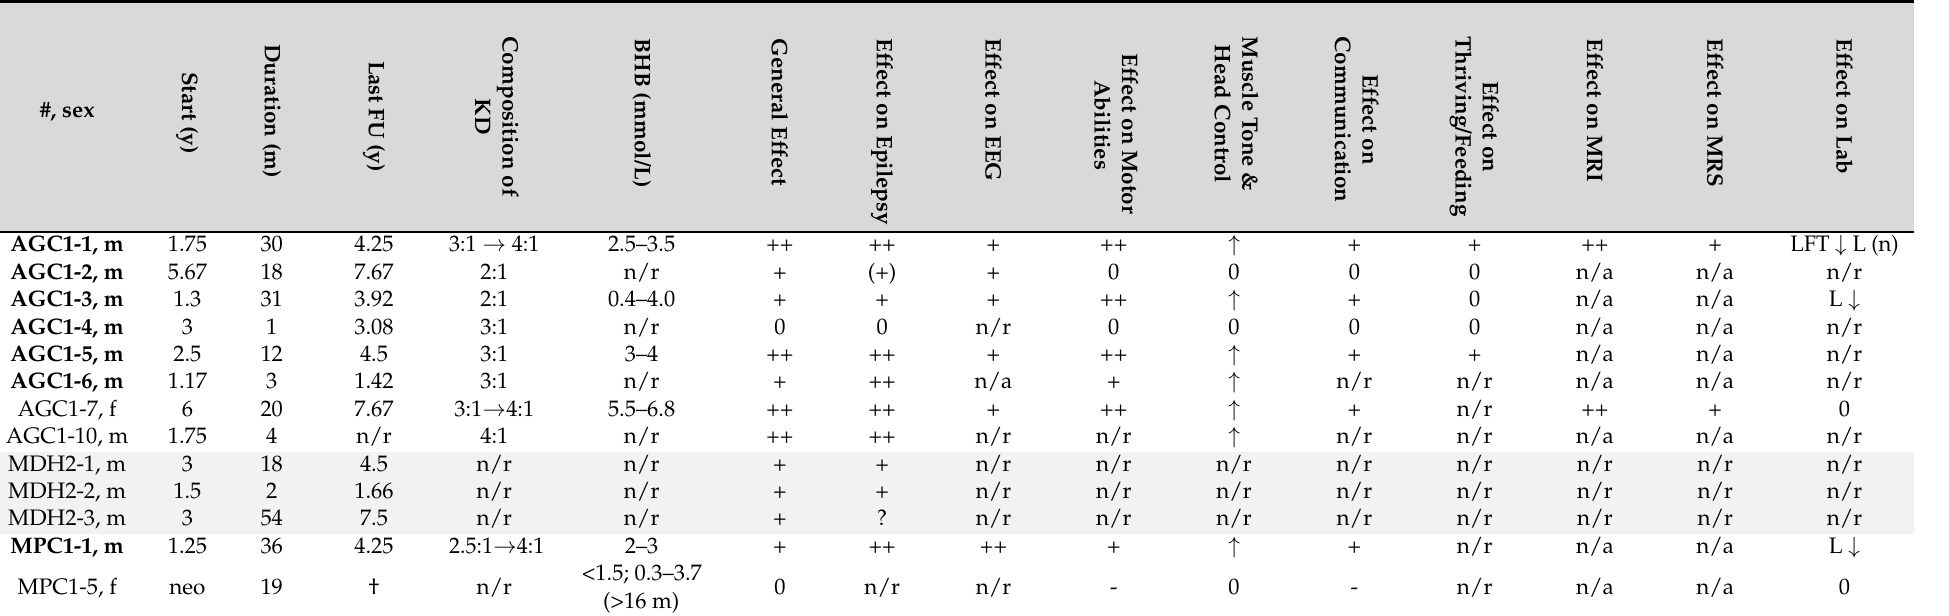
Table 4. Course on ketogenic diet in individuals with neuronal MAS/MPC1 defects